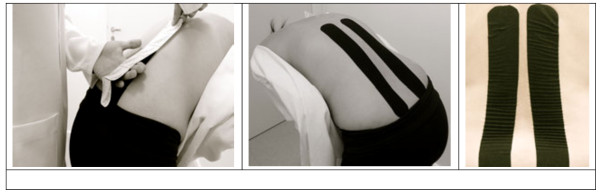
Application of Kinesio Tape [38].